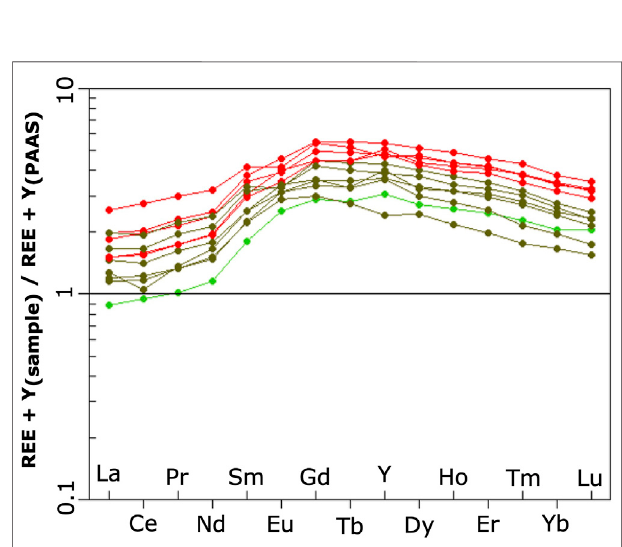
FIGURE 9 | PAAS-normalized REE distribution of P-rich samples ( > 3 wt %) from Welsh Basin ironstone ( Table 2 ). Colours re fl ect facies: blue (cid:1) clastic rich F1 and F3, green (cid:1) F5, brown (cid:1) F6, red (cid:1) F7, red crosses (cid:1) F7 from drill core.